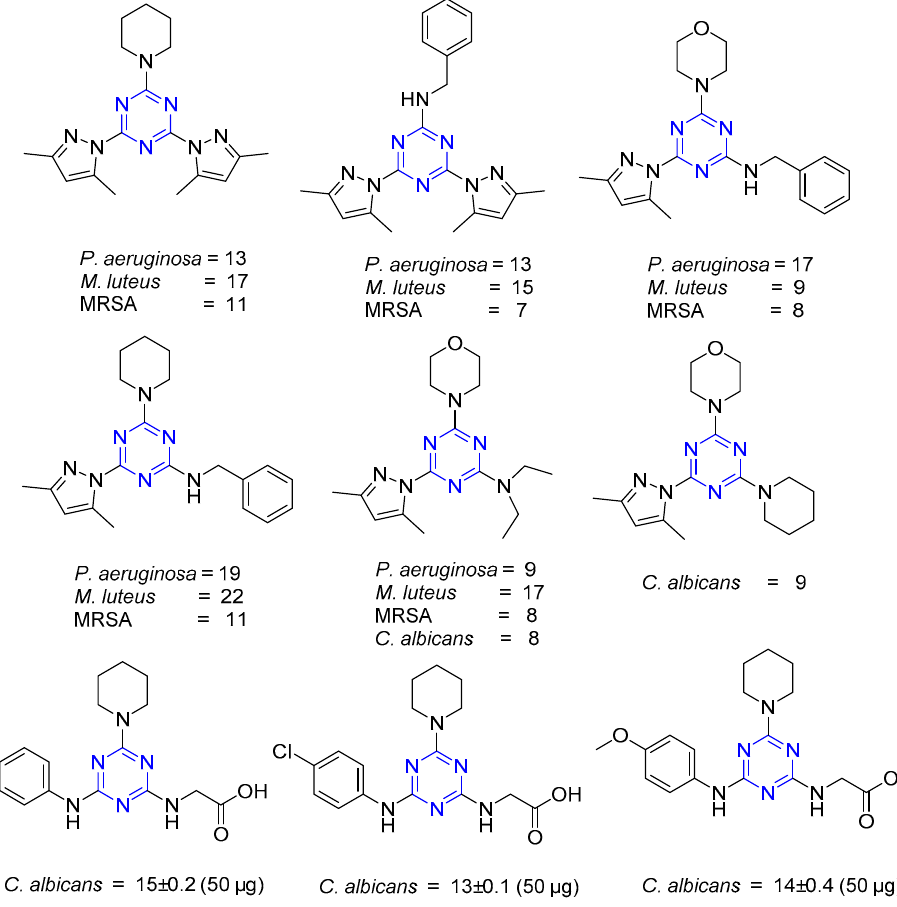
Figure 5. Compounds with antimicrobial activity (as zone of inhibition in mm).